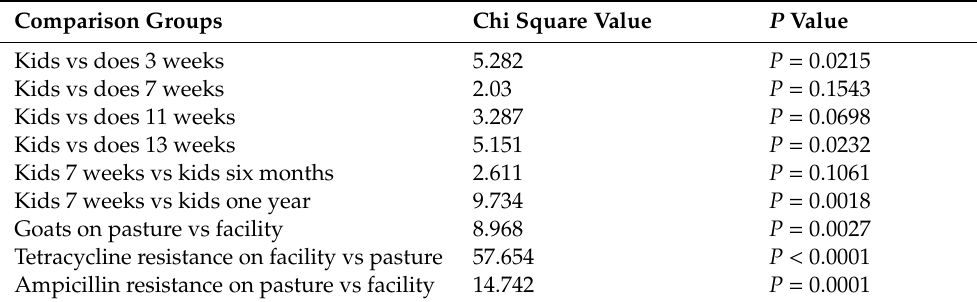
Table A2. Statistical results of comparisons of proportions of antibiotic resistant isolates analyzed using MedCalc